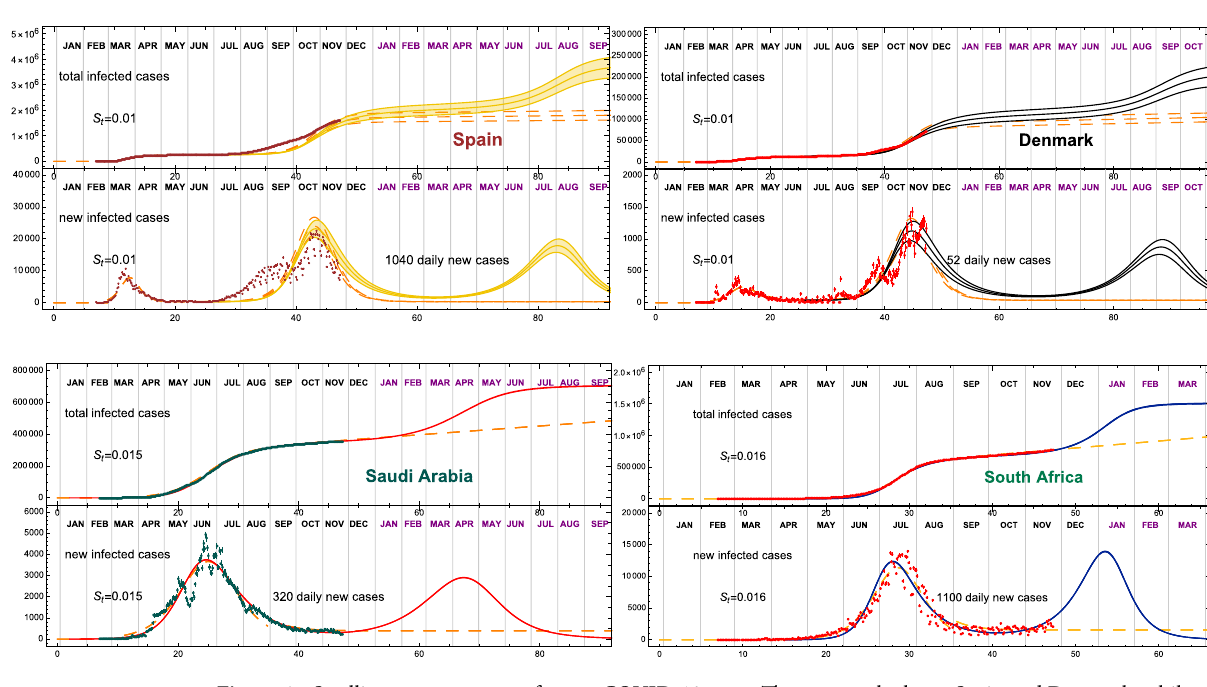
Figure 4. Strolling as a precursor of a new COVID-19 wave. The top panels shows Spain and Denmark, while the remaining European countries included in this study are shown in the Supplementary Information. In the bottom panels we show two sample countries from other regions of the World. In both cases, currently the epidemic is in the strolling regime after the first wave, indicating an imminent restart of the epidemic. In cases with an ongoing strolling, S t is fitted to reproduce the